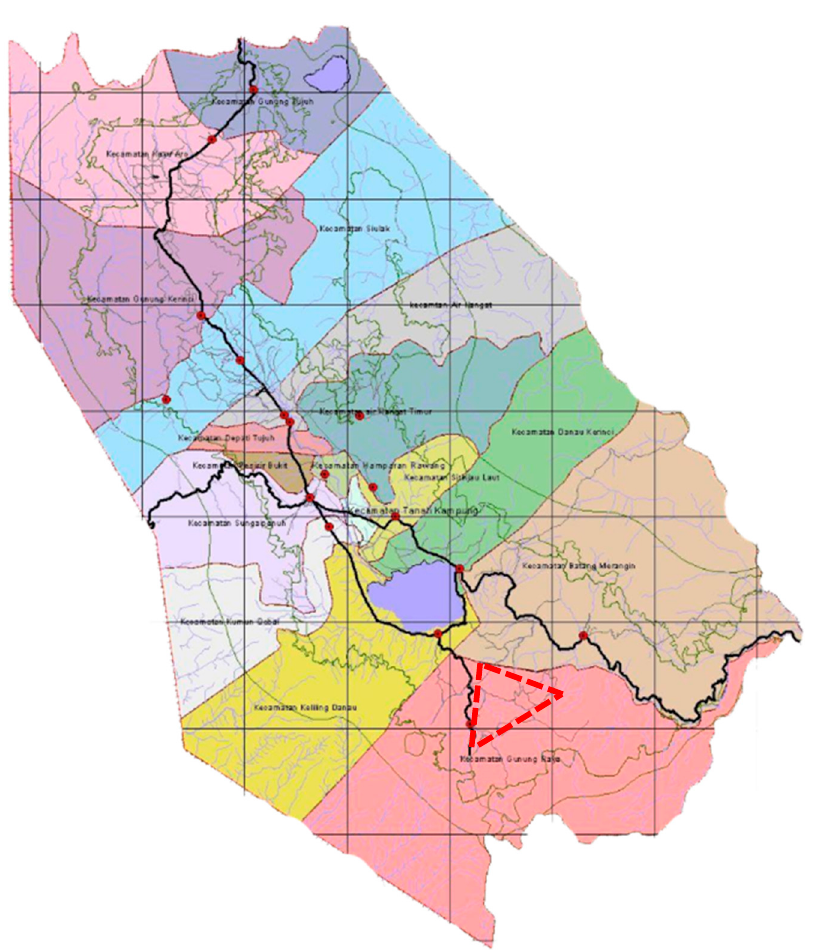
Figure 3. Talang Kemuning village and surrounding [triangle], Bukit Kerman sub-district. Source: Kerinci regency regional land agency, 2017